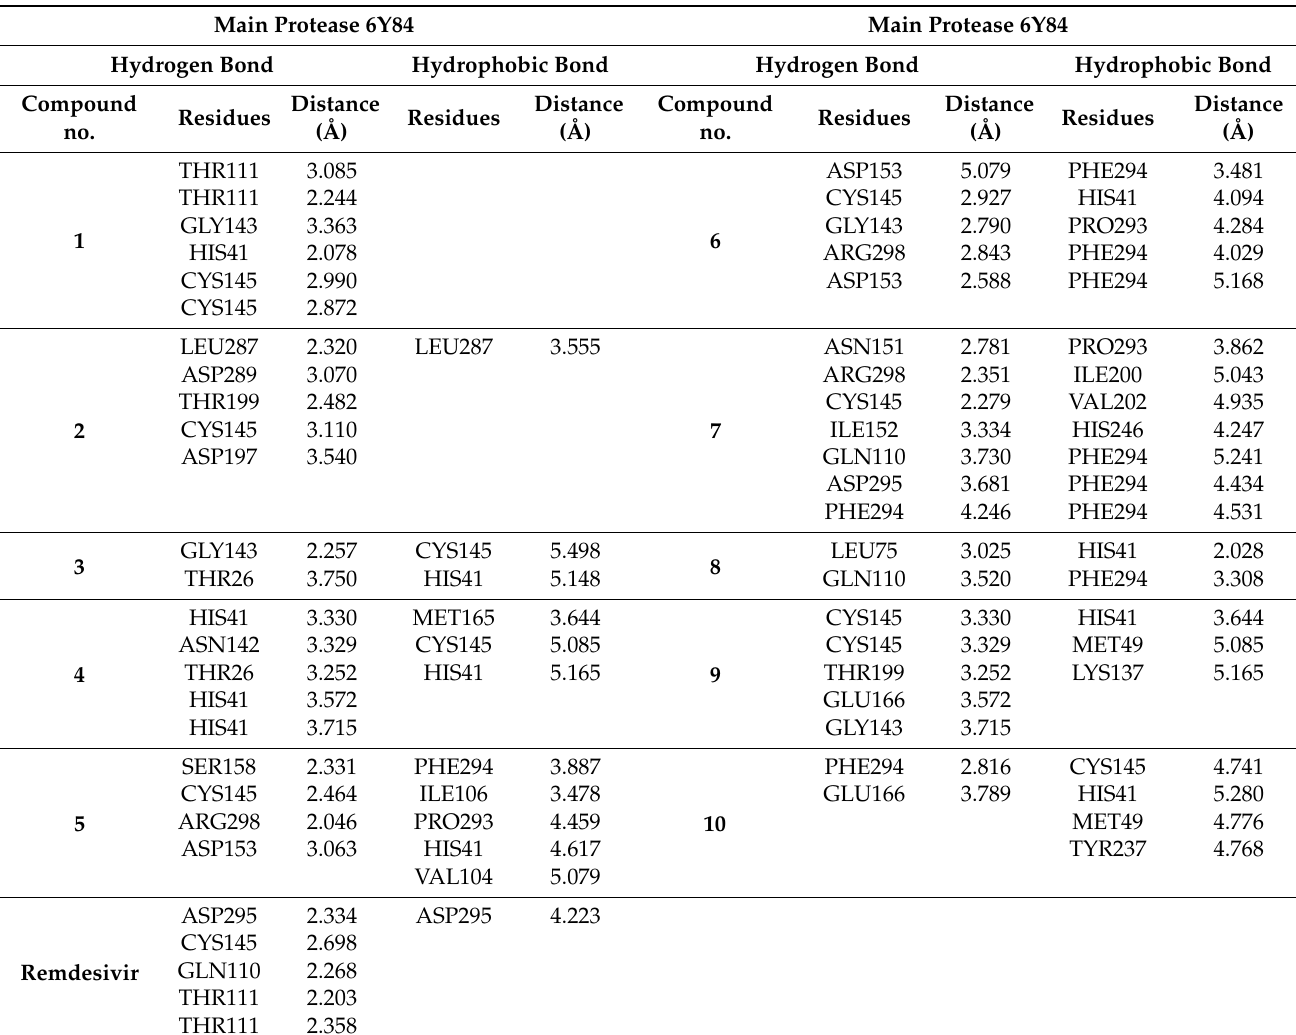
Table 5. Non-bonding interaction data of MGP analogs against M pro